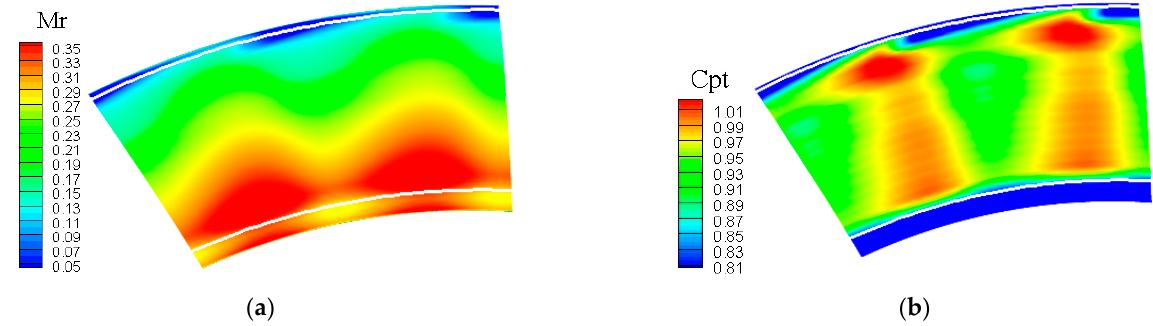
Figure 7. Computed time-averaged relative Mach number ( a ) and absolute total pressure ( b ) in the rotating frame of reference at the stator exit.